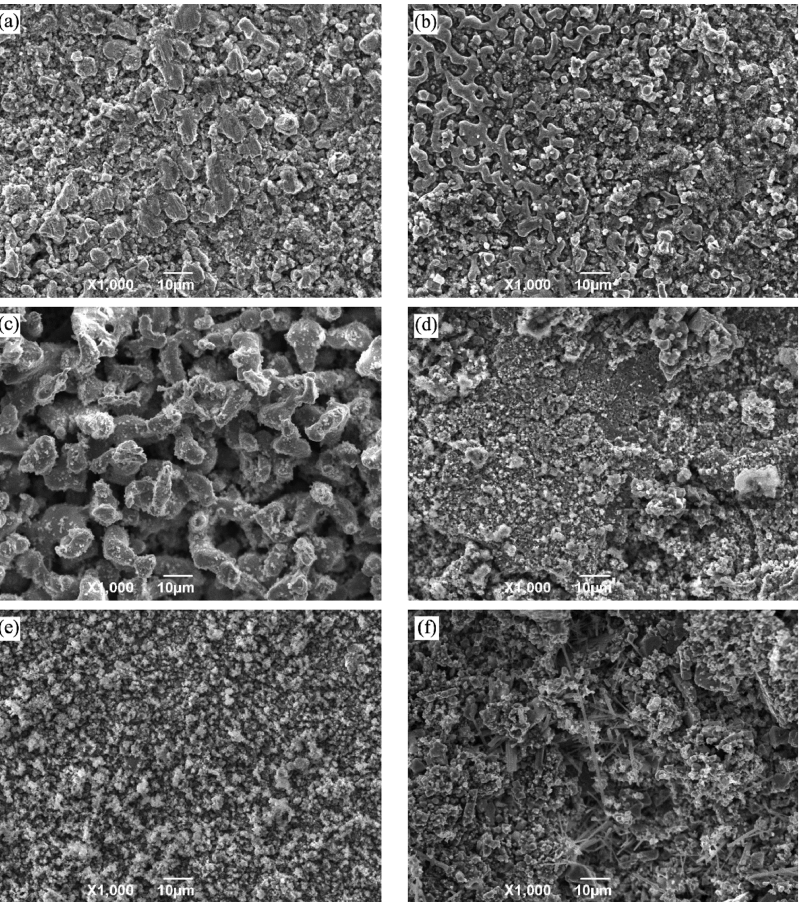
Figure 6: Surface morphologies of Inconel 625 after corrosion in (a) NaCl þ MgCl 2 (2:3), (b) NaCl þ MgCl 2 (7:3), (c) KCl þ MgCl 2 (2:3), (d) KCl þ MgCl 2 (7:3), (e) NaCl þ CaCl 2 (2:3) and (d) KCl þ CaCl 2 (2:3) mixture molten salts after 20 h at 900°C.